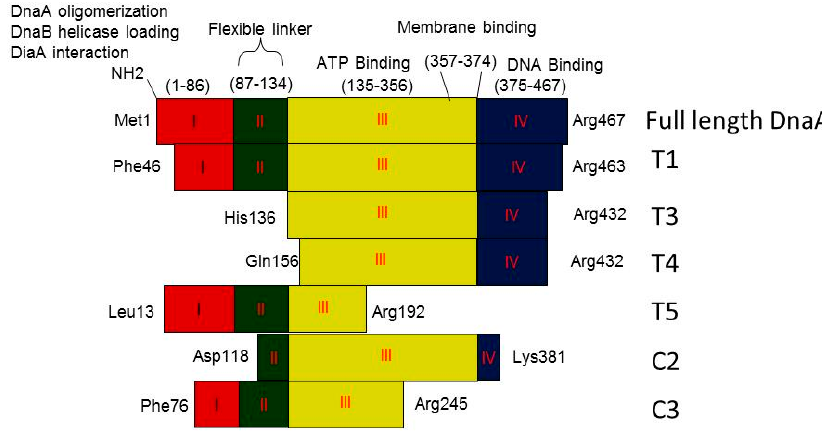
Figure 4. Schematic representation of DnaA domains and Proteolytic fragments obtained with different proteases. Different colors indicate domains I–IV.